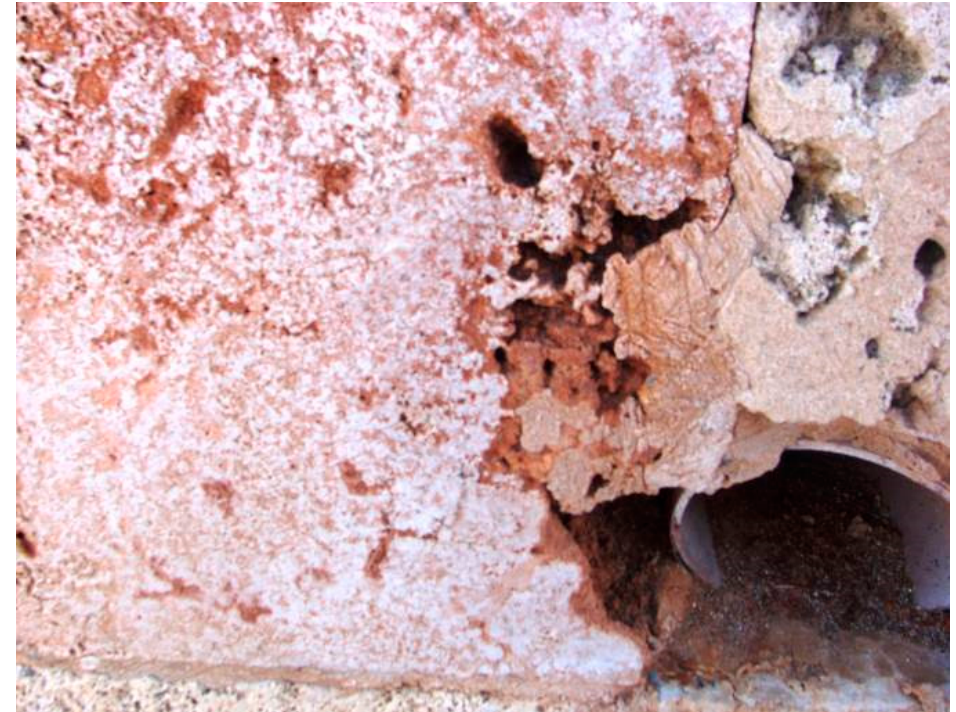
Figure 9. An efflorescence of kurkar siding in the Panorama sea walls. Captured by the author on 27 November 2018.